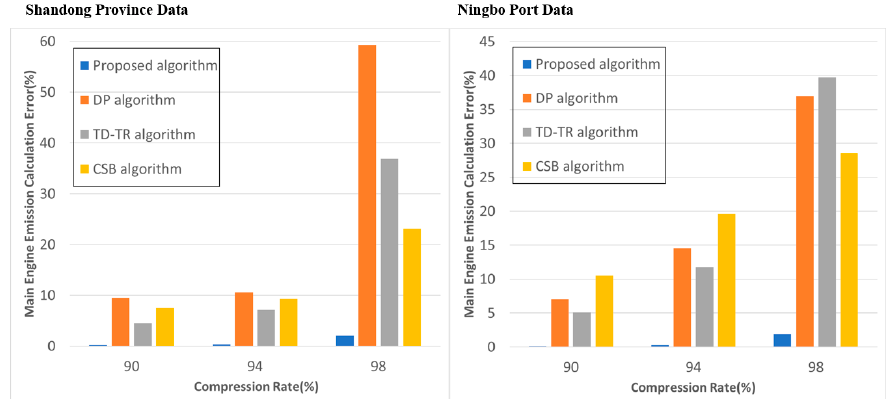
Figure 4. Comparison of emission calculation errors of each compression algorithm at different compression rates. The compression rates are divided into three grades—90%, 94%, and 98%—and the four algorithms are compared horizontally. The left graph shows the comparative analysis of data from Shandong Province, and the right graph shows the comparative analysis of data from the Ningbo Port. At the compression rate of about 98%, the other algorithms have a great error in emission calculation because they lose a large amount of information concerning the ship and the emission calculation, while the proposed algorithm can still maintain a small